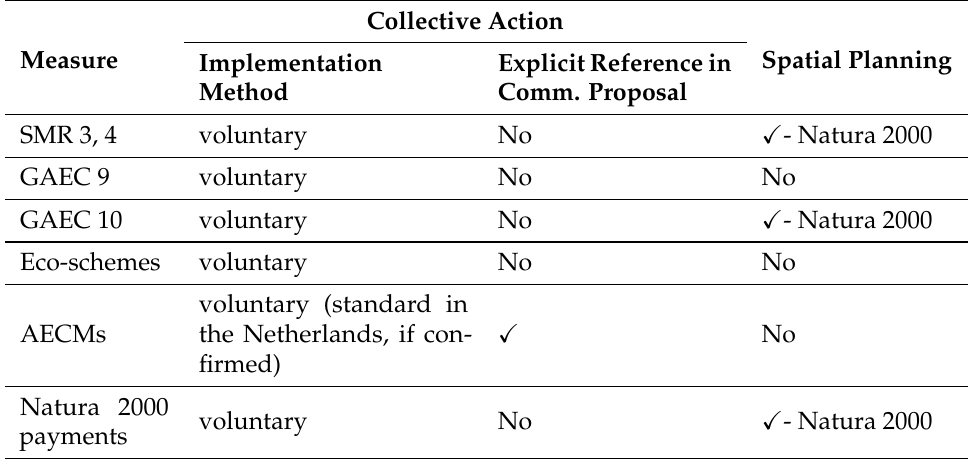
Table 2. Inclusion of the landscape-scale perspective in the Commission